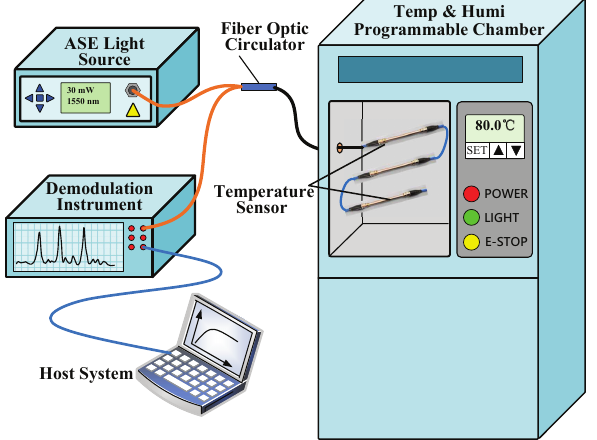
Figure 9. The experimental apparatus of the FBG temperature